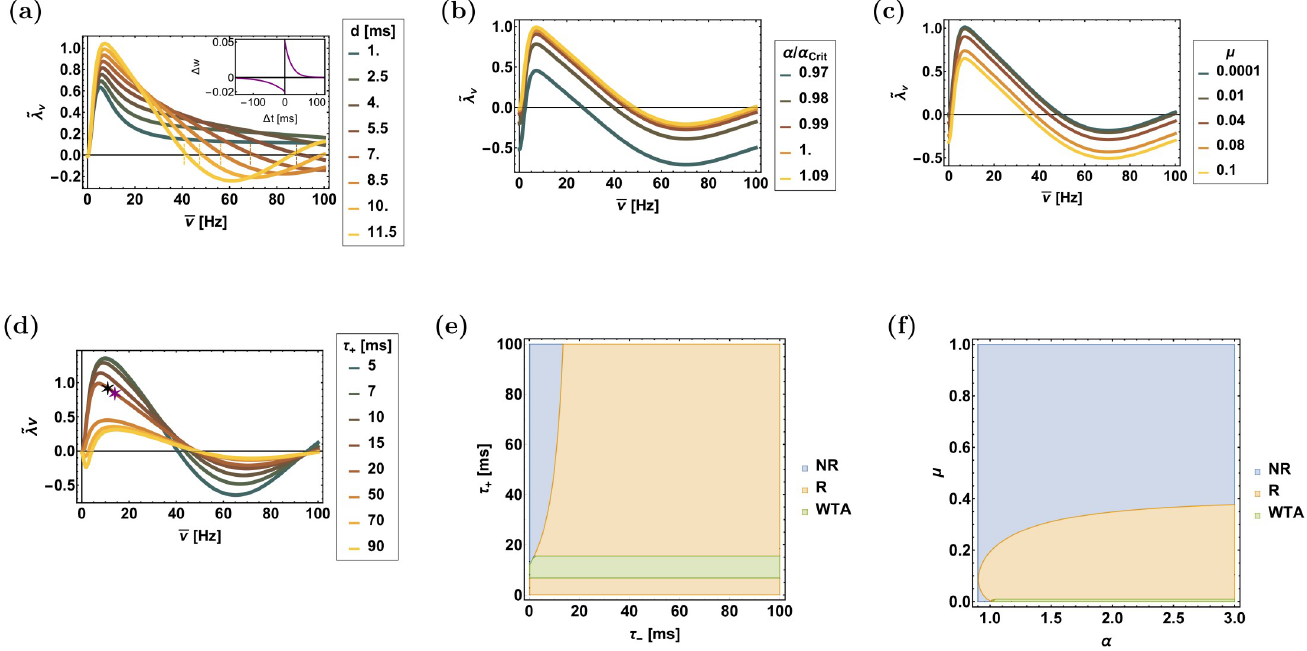
Fig 5. The rhythmic eigenvalue, ~ l , for the asymmetric learning rule, Eq (11). ( a )-( d ) The rhythmic eigenvalue, ~ l n � n ¼ n = ð 2 p Þ , for different values of: the delay, d , in (a), relative strength of depression, α / α c in (b), μ in (c), and of the potentiation time constant, τ + , in (d)—as depicted by color. The black (11Hz) and purple (14Hz) stars in (d) show the eigenvalues with the parameters used in the simulations as shown in Fig 8a–8d. ( e ) and ( f ) The phase diagram of the system showing regions of different types of solutions in the plane of [ τ + , τ − ] in (e) and the plane of [ μ , α ] in (f), as determined by the and λ WTA . The abbreviations to the right of the panels are: NR—non rhythmic, R—rhythmic (multiplexing) and WTA—winner-take-all. Unless stated signs of ~ l n otherwise, the parameters used in this figure are: γ = 1, σ = 0.6, D = 10Hz, N = 120, τ − = 50ms, τ + = 20ms, μ = 0.01, α = 1.1 and d = 10ms. In (d) μ = 0.011.